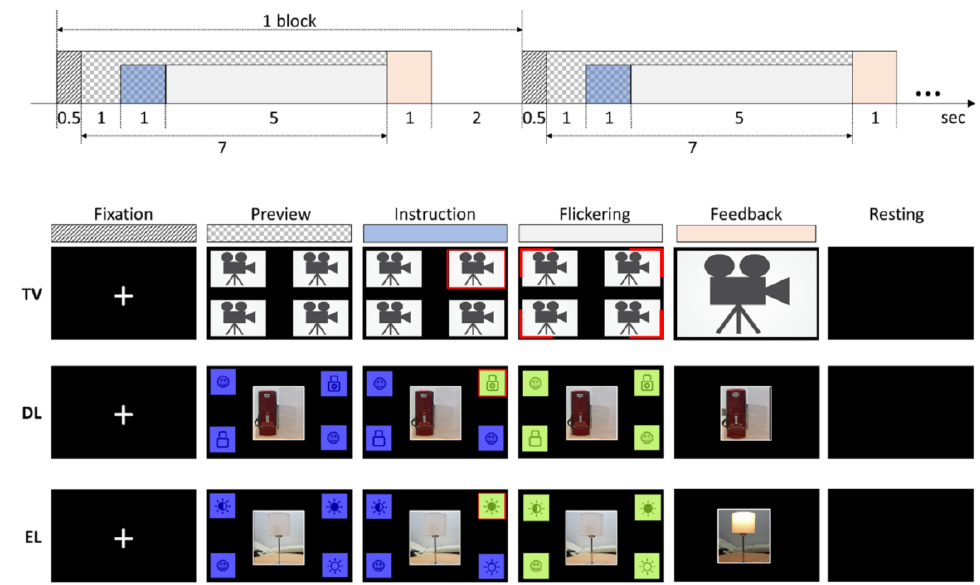
Figure 1. Experimental paradigm and stimulus sequence for each device control. ( Top panel ) Task protocol for each block. One block implies selecting one target at once. ( Bottom panel ) Stimulus sequence for each device; TV, DL (door lock), and EL (electric